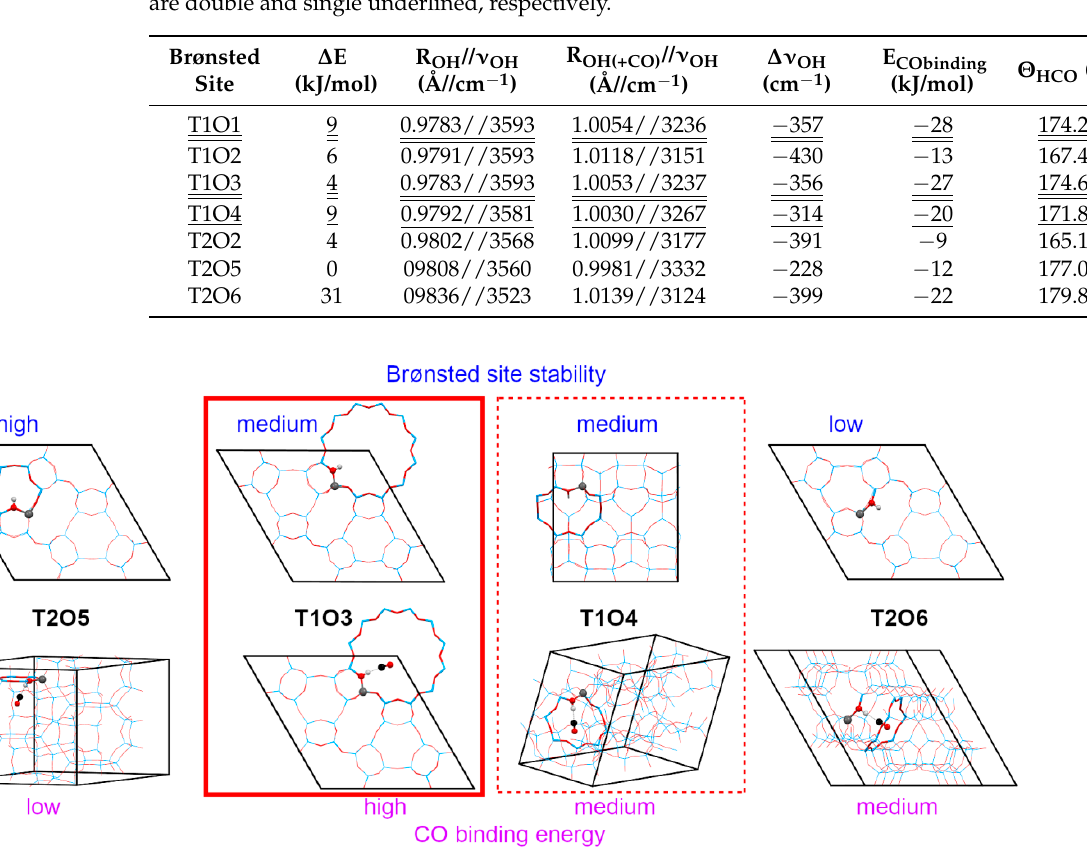
Figure 5. CO adsorption on Brønsted site In MAZ zeolites, as predicted by periodic DFT modeling. T x O y denotes Brønsted acid sites with Al occupying the T x crystallographic position and the protonated O atom situated in y crystallographic sites (the MAZ lattice with distinct T and O crystallographic positions is shown in the upper insert). The formation of stable carbonyls is likely due to Brønsted sites compromising their intrinsic stability and the strength of CO binding. The proposed assignment of experimental OH bands is as follows: (1) the more red-shifted band is due to the more stable carbonyls in the large 12T cavity (solid red frame), and (2) the less red-shifted band is due to the less stable carbonyls in the more confined 8T cavity (dotted red frame). The colors for the atoms are: Al—grey, Si—blue, O—red, H—white, C— black. Table 2. The selected properties of Brønsted site In MAZ, bare and with adsorbed CO molecules, as predicted by periodic DFT calculations: relative energetic stability ( Δ E), OH bond lengths (R OH ), scaled frequencies ( ν OH ) and the value of red- shift upon CO adsorption ( Δν OH ), CO binding energy (E CObinding ) and HCO angle ( Θ HCO ). The sites assigned to the experi- mentally observed more and less red-shifted OH bands (with the experimental Δν OH being − 370 and − 270 cm − 1 , respec- tively) are double and single underlined, respectively.